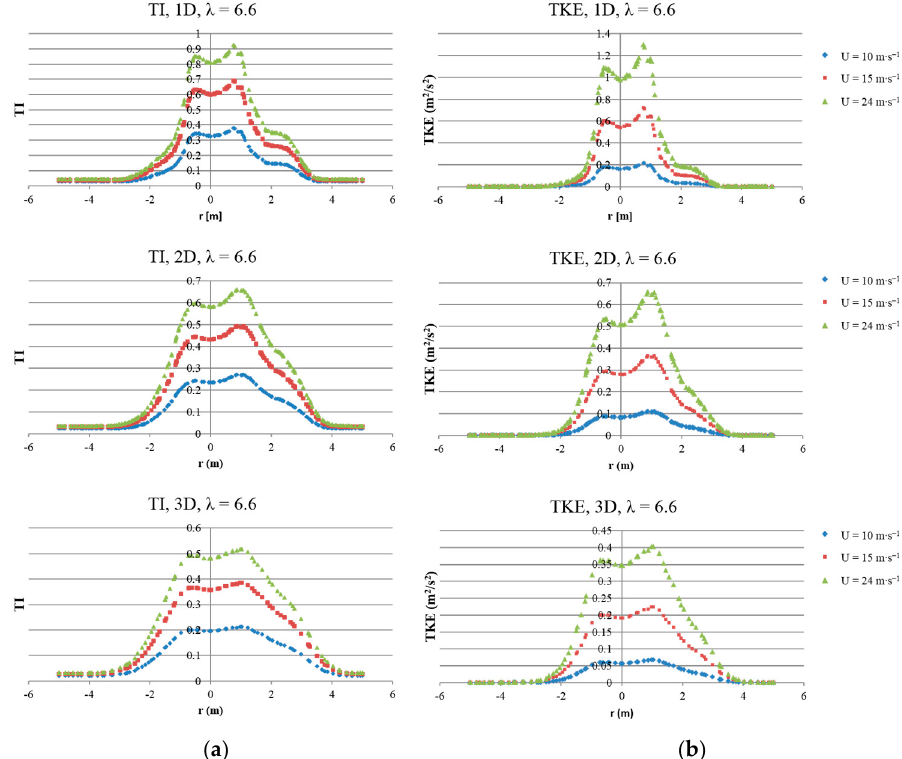
Figure 12. ( a ) Turbulence Intensity (TI) as a function of Velocity and downstream distances in the near wake; ( b ) Turbulence Kinetic Energy (TKE) as a function of Velocity and downstream distances in the near